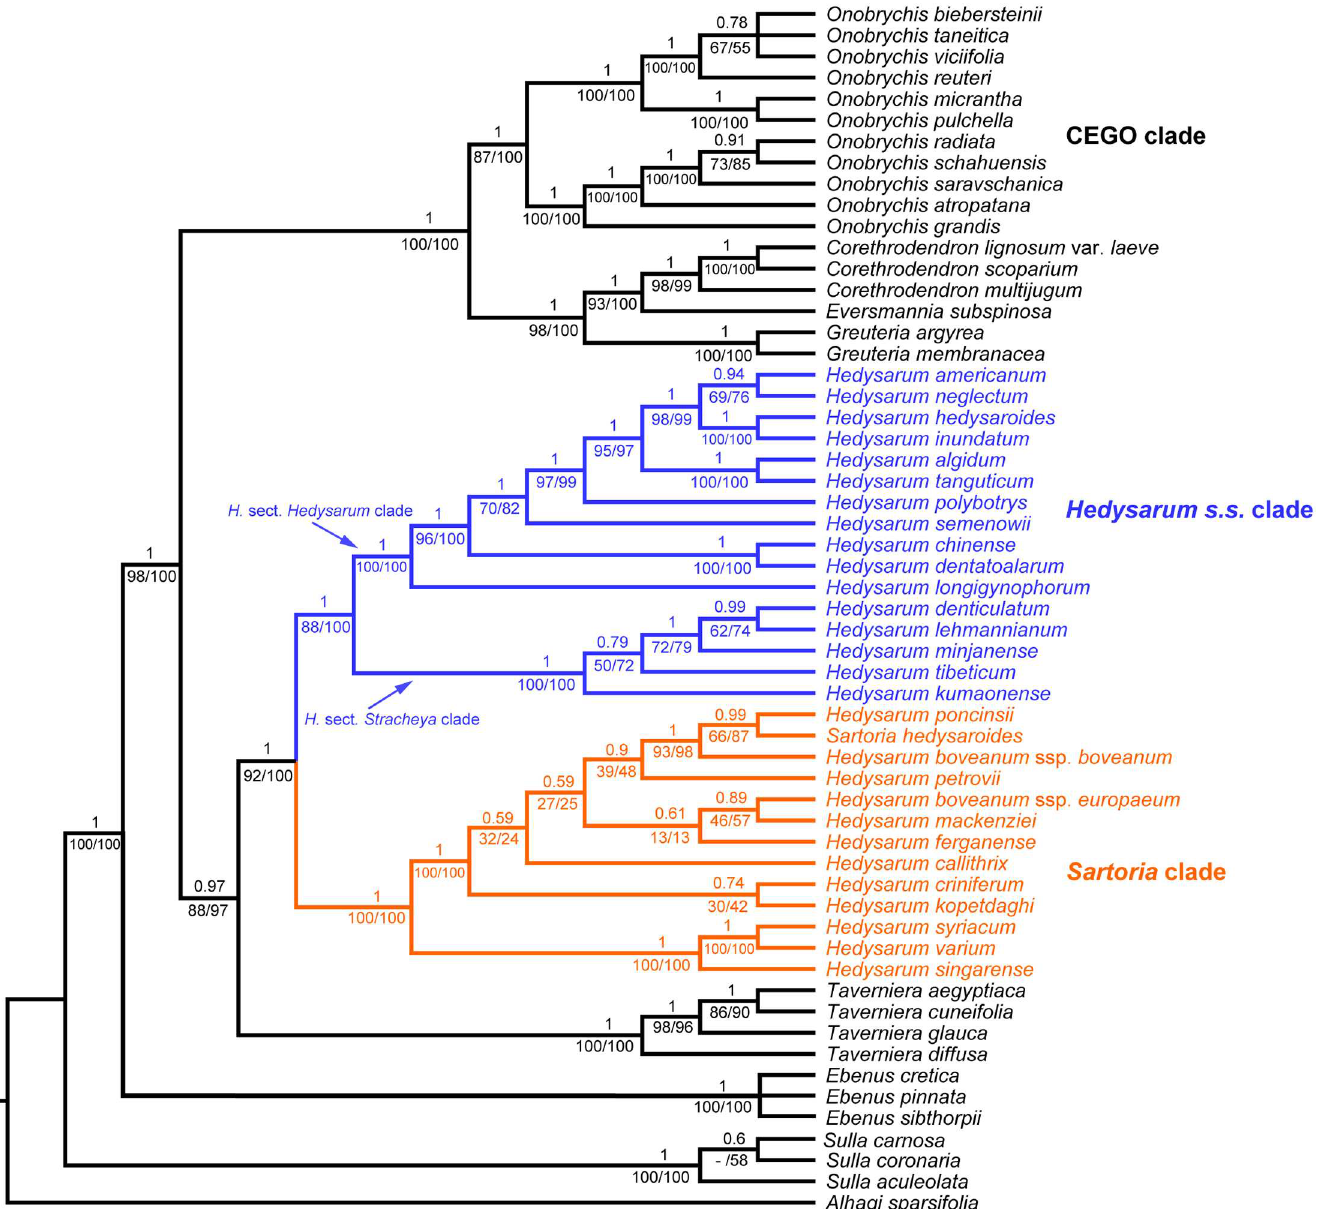
Fig 2. Bayesiantree based on the concatenated plastid psbA-trnH , trnC-petN , trnL-trnF , trnS-trnG , and petN-psbM sequences. The Bayesian posterior probabilities are above the branches, and the maximum parsimony (left) and maximum likelihood (right) bootstrapsupport values are belowthe branches. A dash indicates a branchthat is not found in the maximum parsimony